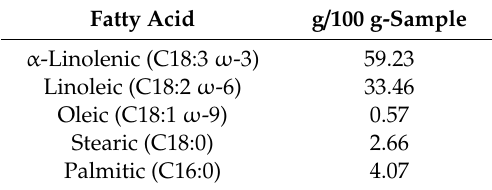
Table1. Fattyacidcomposition(g / 100g)ofsachainchioilbeforethesimulatedgastrointestinaldigestion. Fatty Table 1. Fatty acid composition (g/100 g) of sacha inchi oil before the simulated gastrointestinal digestion.